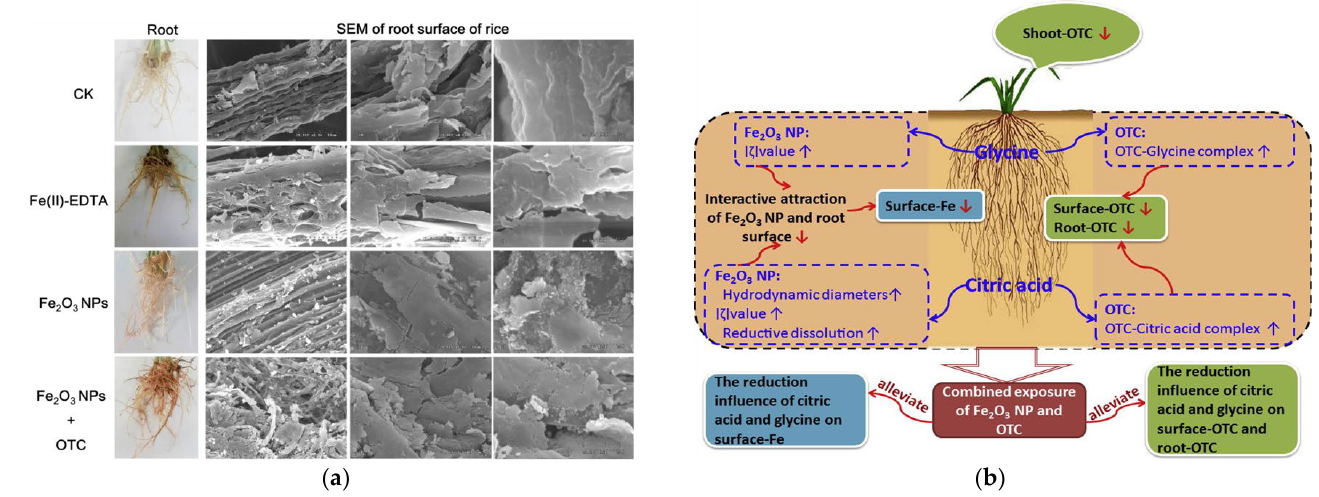
Figure 2. ( a ) Rice root surface images. Reprinted with permission from Ref. [30]. 2019, Springer- Verlag; ( b ) diagram showing that citric acid and glycine reduce the uptake and accumulation of Fe 2 O 3 nanoparticles and oxytetracycline in rice seedlings upon individual and combined exposure. Reprinted with permission from Ref. [31]. 2019, Elsevier.